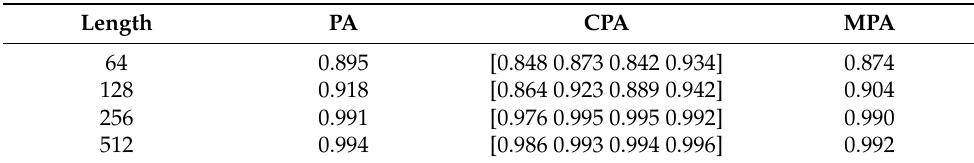
Table 2. Experimental results under different lengths.